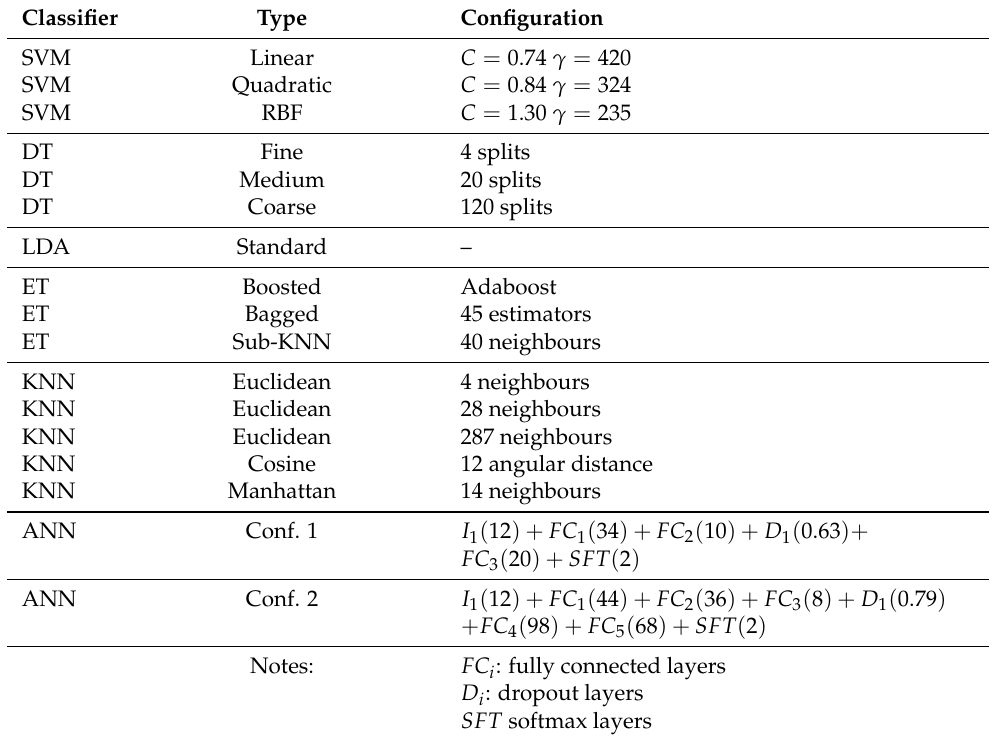
Table 3. Basic configuration of each